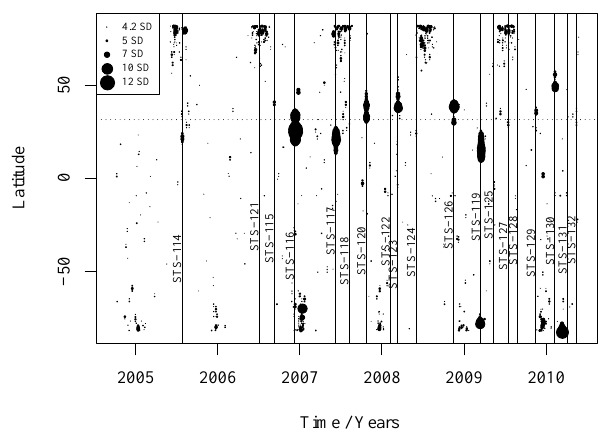
Fig. 5. Detected points as a function of time and latitude. The ver- tical lines mark the launch dates of space shuttle missions. Dot size is proportional to the amount by which 4 standard deviations (SD) is exceeded. The thin dotted line marks 31.5 ◦ N: approximately the latitude at which the plume is